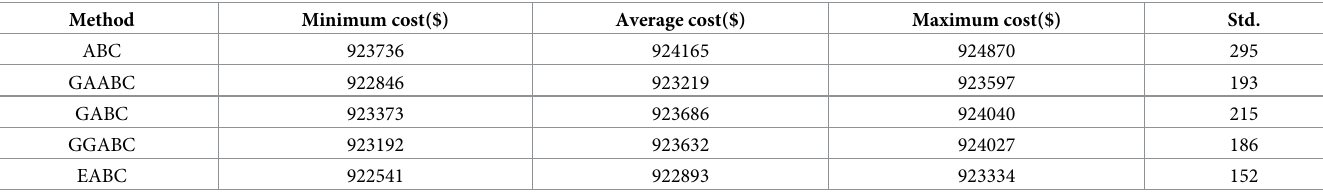
the earlier stage, but drops it significantly in mid-late period. The optimization speed of GABC and EABC is higher than that of ABC in the process of optimization. In the first 100 genera- tions, the optimization speed of EABC is almost the same with that of GABC, but more supe- rior after 100 generations. In respect of optimization efficiency, GABC and EABC are also Table 8. Comparison of the results of ABC